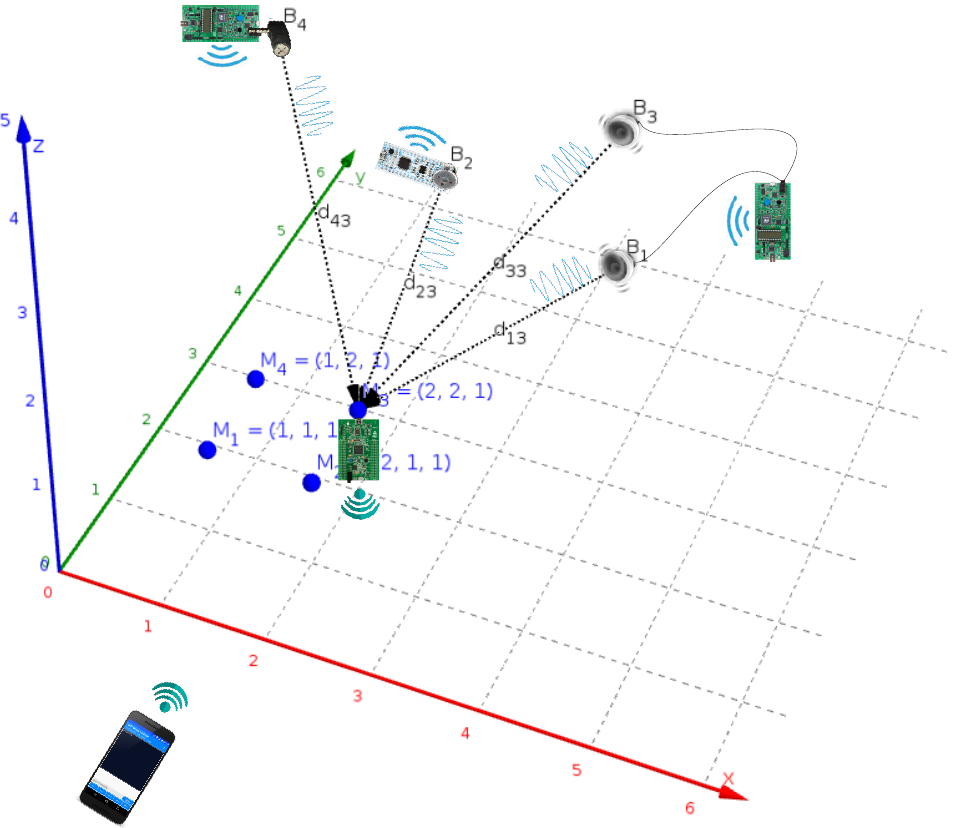
Figure 1. Overview of the proposed local positioning